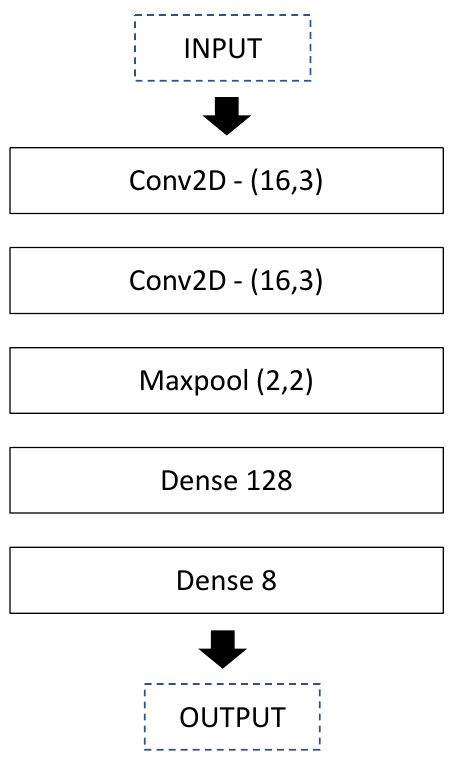
Figure 4. The max-pooling operation. There are four sub-matrices in the left matrix. The max-pooling operation (middle matrix) takes every maximum value of sub-matrices to the right matrix.